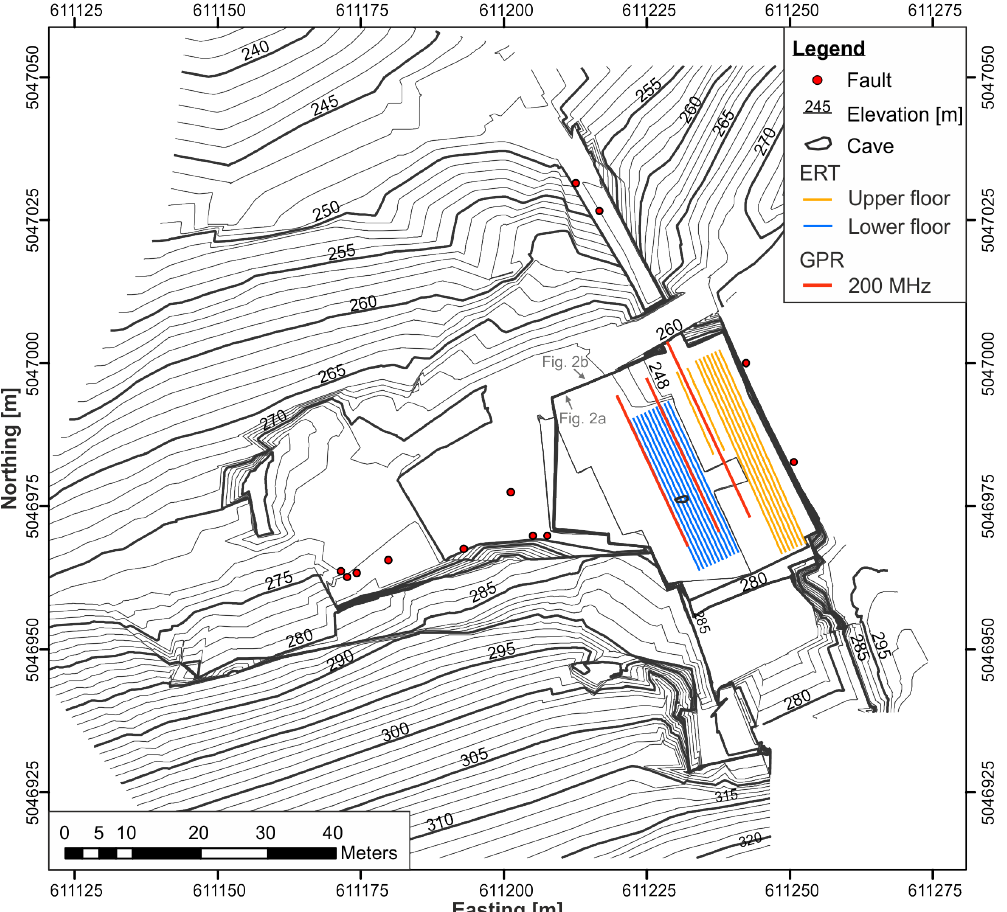
Figure 3. Overview map of the study site, showing the elevation profile, location of major observed faults, and ERT and ground penetrating radar (GPR) survey lines. The locations and directions of the photographs of Figure 2 are also